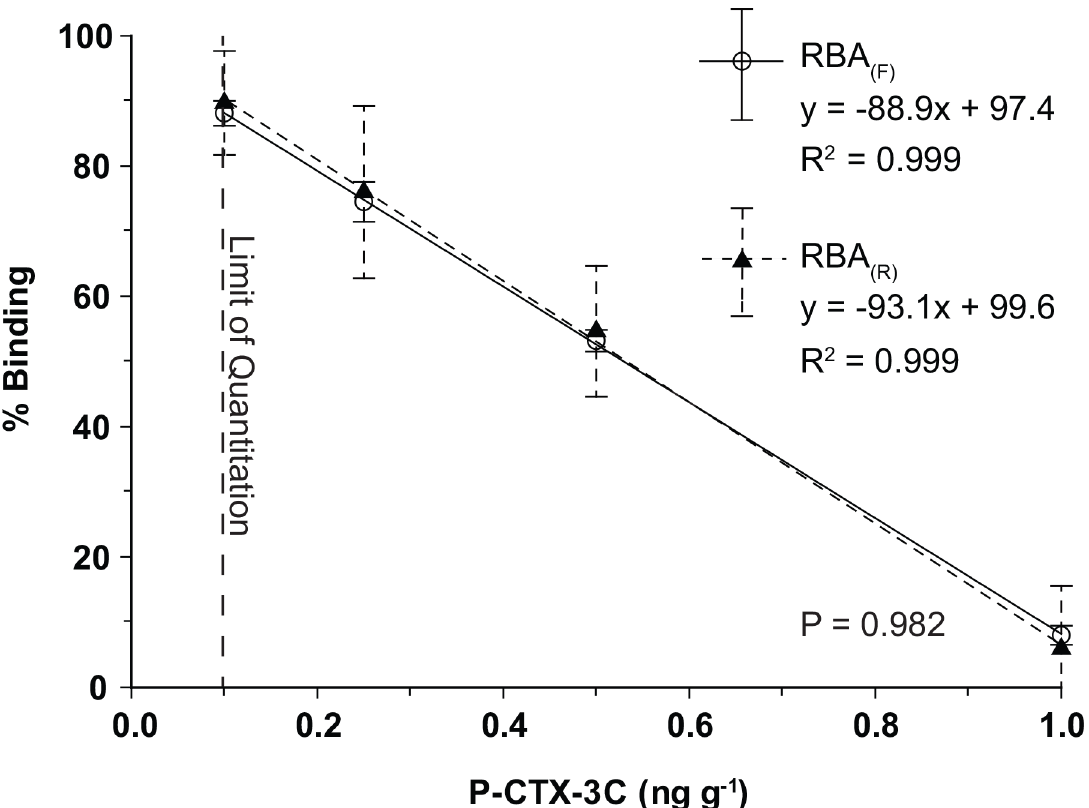
Fig 6. RBA (F) and RBA (R) Linear Standard Curves. Lower ciguatoxin concentrations found in fish surveyed in this study were accurately measured using a linear standard curve consisting of 0.10, 0.25, 0.50 and 1.0 ppb P-CTX-3C. Results were equivalent for the RBA (F) (open circle; solid line) and RBA (R) (closed triangle; dashed line) (t-test, P =